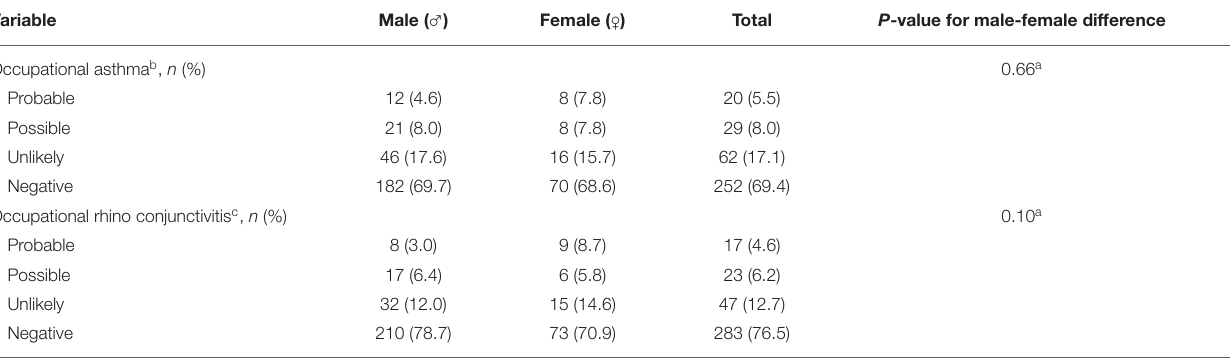
TABLE 4 | Prevalence of occupational asthma and occupational rhino